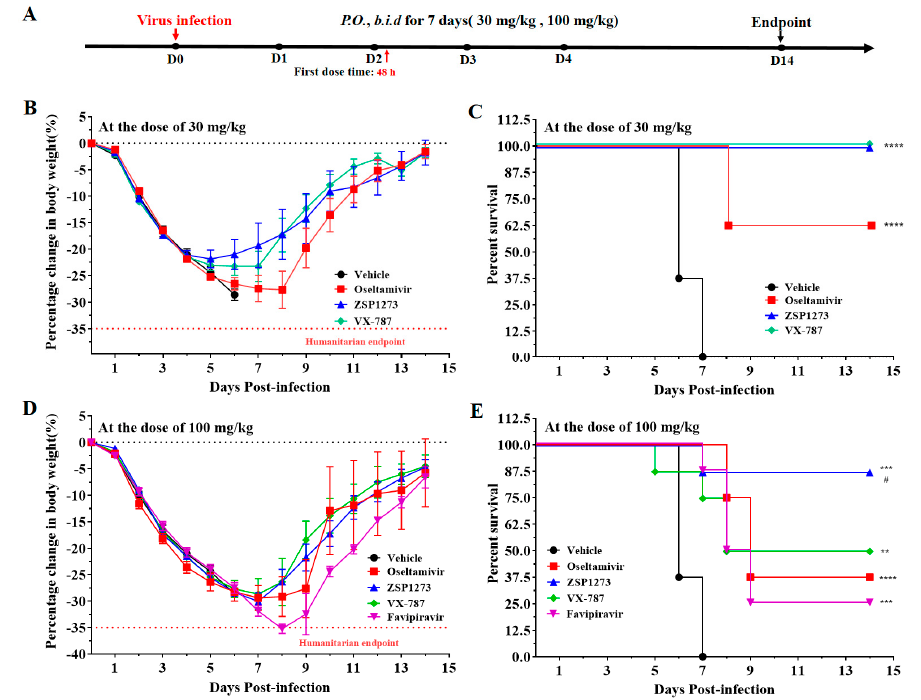
Figure 6. The antiviral activity of ZSP1273 in murine infection experiment III (n = 8, mean ± SEM): ( A ) Flowchart of the experiments: the day of H1N1 infection is defined as day 0, the first day after infection is denoted as day 1, and so forth. ( B , C ) Changes in the weight and survival rate, respectively, of mice in each group after infection at the dose of 30 mg/kg. ( D , E ) Changes in the weight and survival rate, respectively, of mice in each group after infection at the dose of 100 mg/kg. Based on the weight on the day of infection, a mouse with more than 35% weight loss (indicated by the dashed line) would be considered dead, according to the IACUC. Error bars represent the standard error of the mean value. Note: ** p < 0.01, *** p < 0.001, **** p < 0.0001 (vs. vehicle); # p < 0.05 (vs. favipiravir, 100 mg/kg).